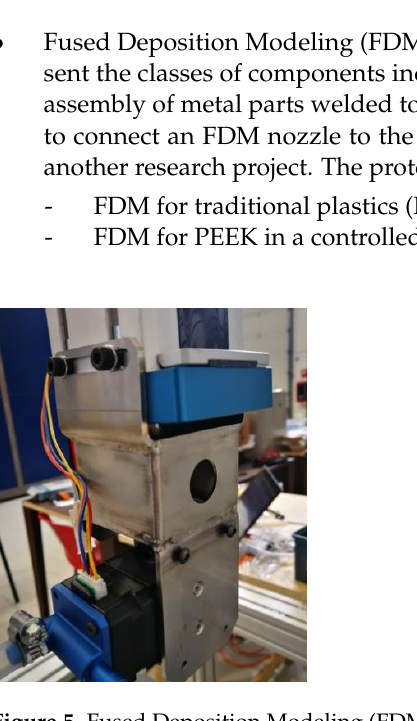
Figure 4. Real automotive manifold.